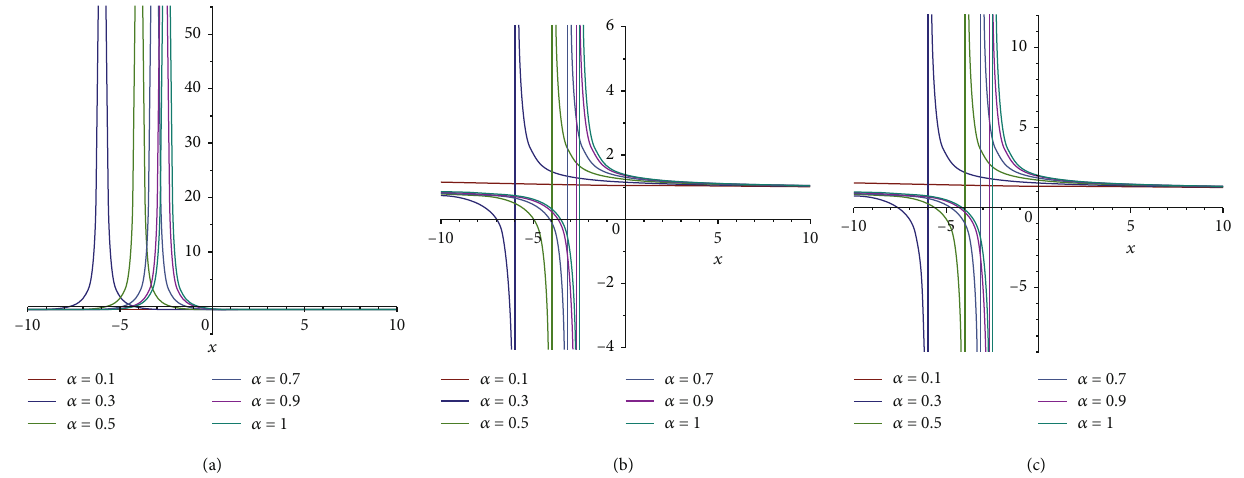
= b = τ = c = 1, t = 1, and a − 1 0